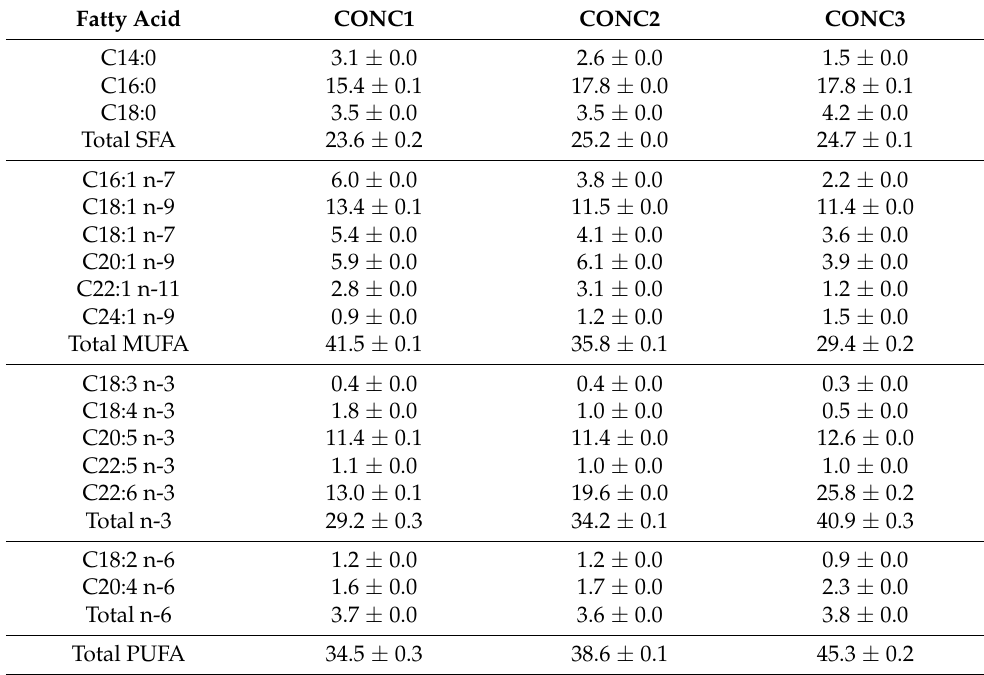
Figure 3. Proportion (%) of molecular weight (MW) distributions of commercial fish protein con- centrates, hydrolysates, and hydrolyzed fish protein. Fish protein concentrates = CONC1–3, fish protein hydrolysates = HYDR1–2, hydrolyzed fish collagen = COLL1. Different letters within the same molecular weight grade indicate a statistically significant difference with ANOVA post hoc pair comparison ( p < 0.05). Table 5. Fatty acid composition (percent of total fatty acids) of the commercial fish protein concen- trates (CONC1–3) with mean and standard deviation of two replicate measurements. There were no statistically significant differences between the samples with Kruskal–Wallis one-way analysis of